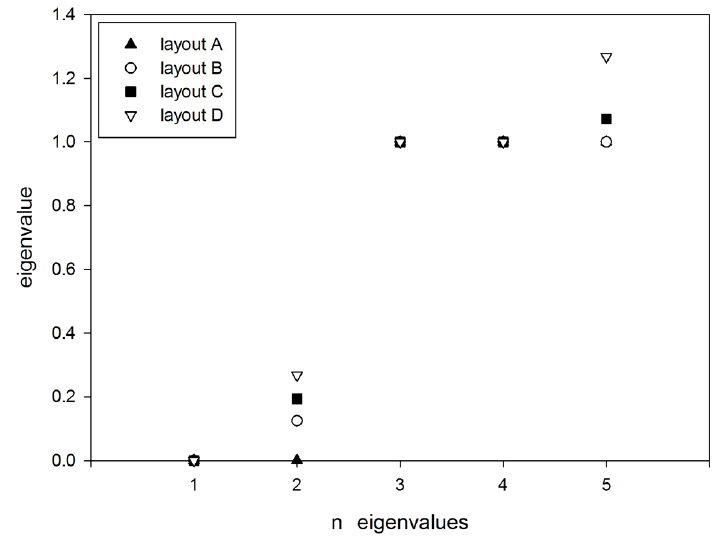
Figure 3. First five eigenvalues for the cases A, B, C, and D of the Example Network.